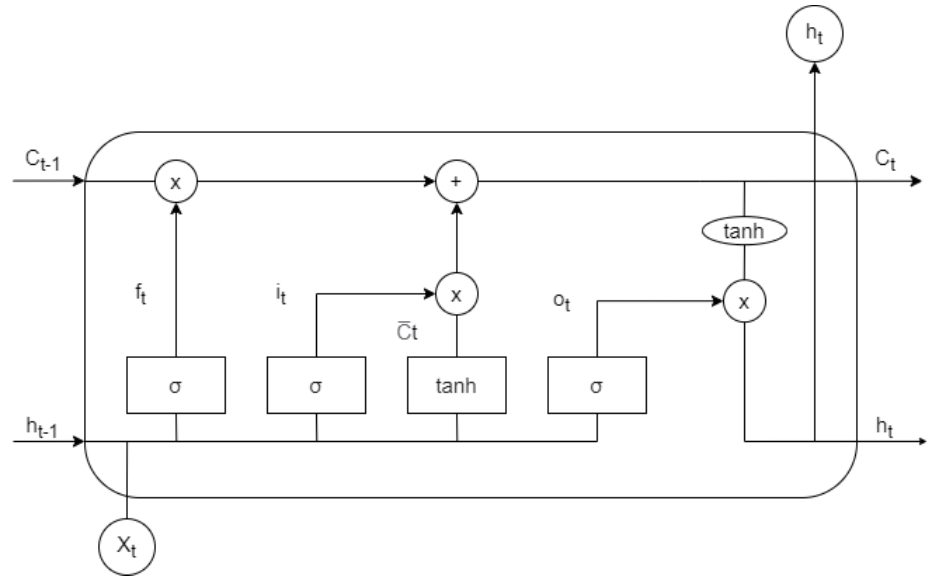
Figure 4. LSTM cell